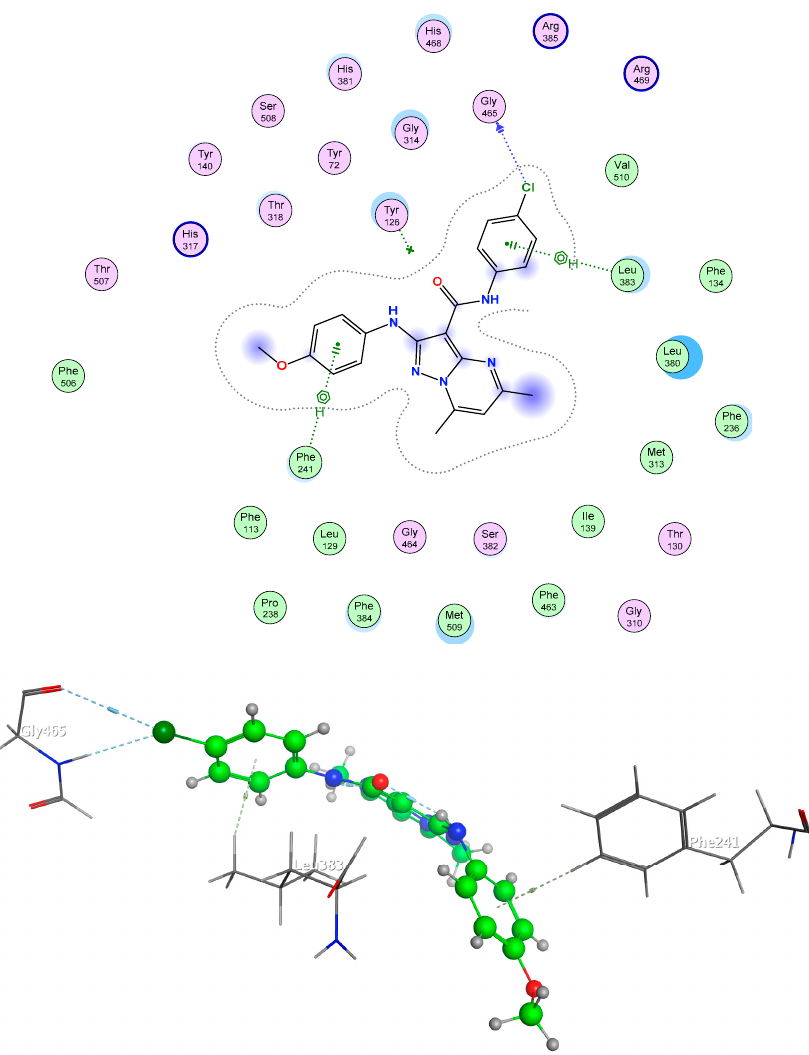
Figure 5. 2D and 3D interaction diagrams of compound 5c with 14- α demethylase.